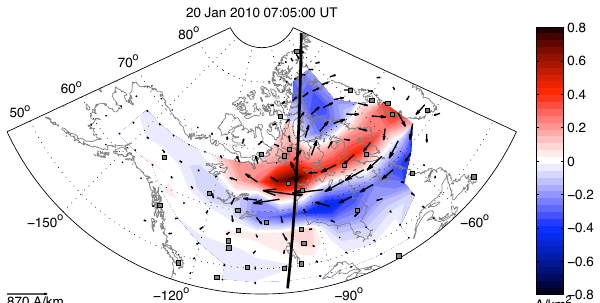
Fig. 4. Horizontal distribution of equivalent currents (black vectors) from the THEMIS, CARISMA, CANMOS, MACCS and Greenland magnetometer data during substorm 1. The blue and red colours in- dicate FAC density up and down, respectively, estimated from the vorticity of the horizontal currents. The strongest currents occurred around the midnight meridian (black line) in the vicinity of the Ha- rang reversal region at 07:05UT. Gray squares mark the CARISMA magnetometer